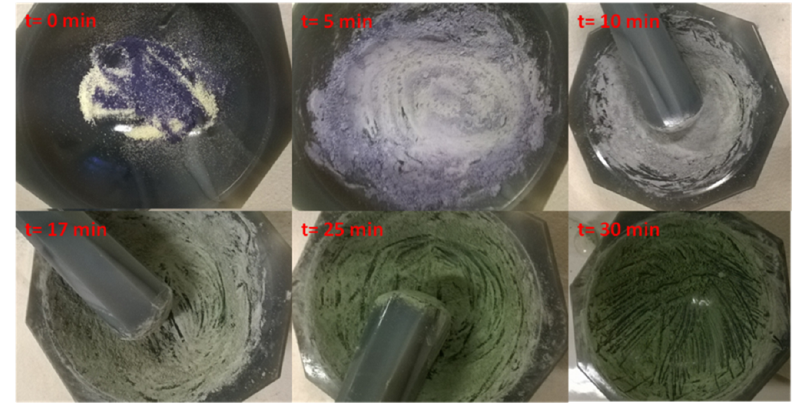
Figure 36. Monitoring of the synthesis of Cu-42 over time. Reproduced with permission from the authors of [69]. Copyright 2017 John Wiley & Sons Ltd.